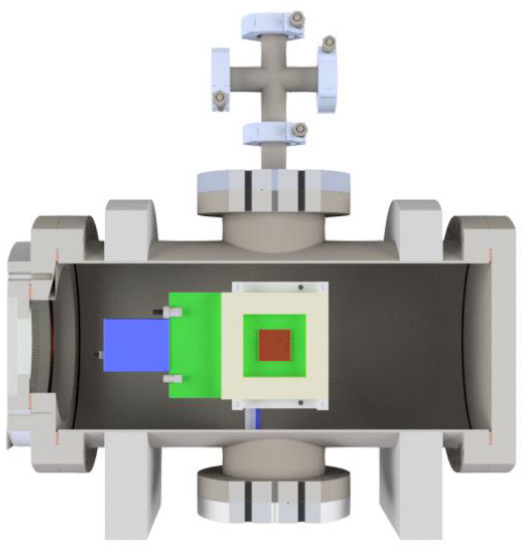
Figure 18. A cross-sectional view of the planned vacuum vessel housing the GEMTEQ for sealed low-pressure applications. The GEMTEQ is located in the centre of the vacuum vessel and the colors show the different materials and components: the aluminum vessel (gray), the FITPix (blue), the PCB (green), the GEM frames (beige) and the Pixelman ASICs (brown). The GEMs are not included in this drawing.